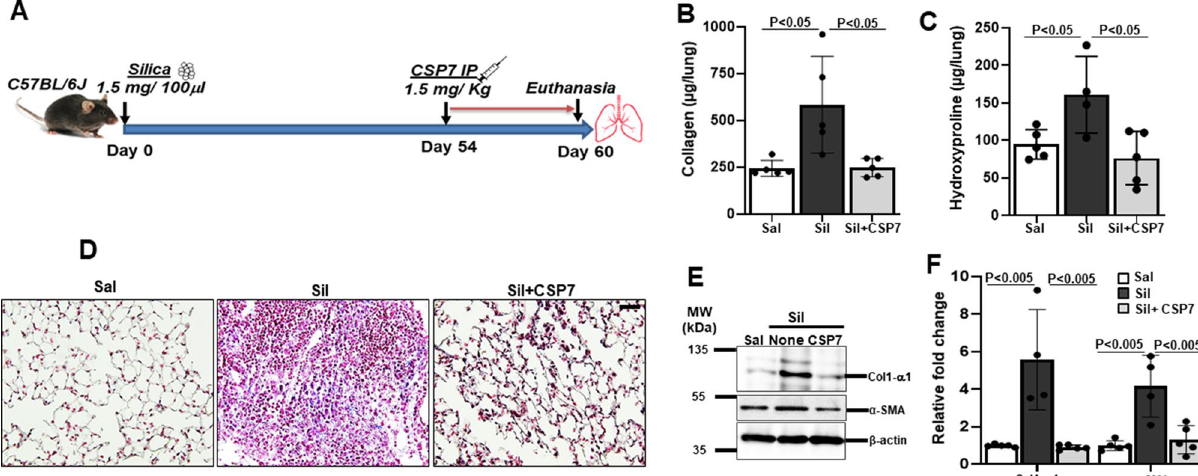
Figure 1. CSP7 mitigates silica-induced existing PF. ( A ) Schematic diagram showing the experimental design. ( B ) Bar graphs showing inhibition of total lung soluble collagen and ( C ) hydroxyproline contents in mice (n = 5–7 per group) with silica-induced PF and subjected to CSP7 treatment for last 7 days as in Fig. 1A. ( D ) Representative trichrome stained lung tissue sections showing increased Col1 deposition in silica instilled WT mice and its reversal by CSP7 treatment. Scale bar: 20 μm. ( E ) Representative western blot images of lung homogenates showing marked increase in Col1 and α-SMA protein expression in silica treated WT mice, which is attenuated after CSP7 treatment. β-actin serves as loading control. MW: Molecular weight. kDa: Kilodalton. ( F ) Bar graph depicting decreased expression of Col1 and α-SMA mRNA in lung homogenates of CSP7 treated WT mice (n = 5) exposed to silica. Each experiment was repeated at least 2–3 times and data is presented as mean + SD and p values were obtained by one-way Anova with Turkey’s multiple comparison test and log-rank tests,